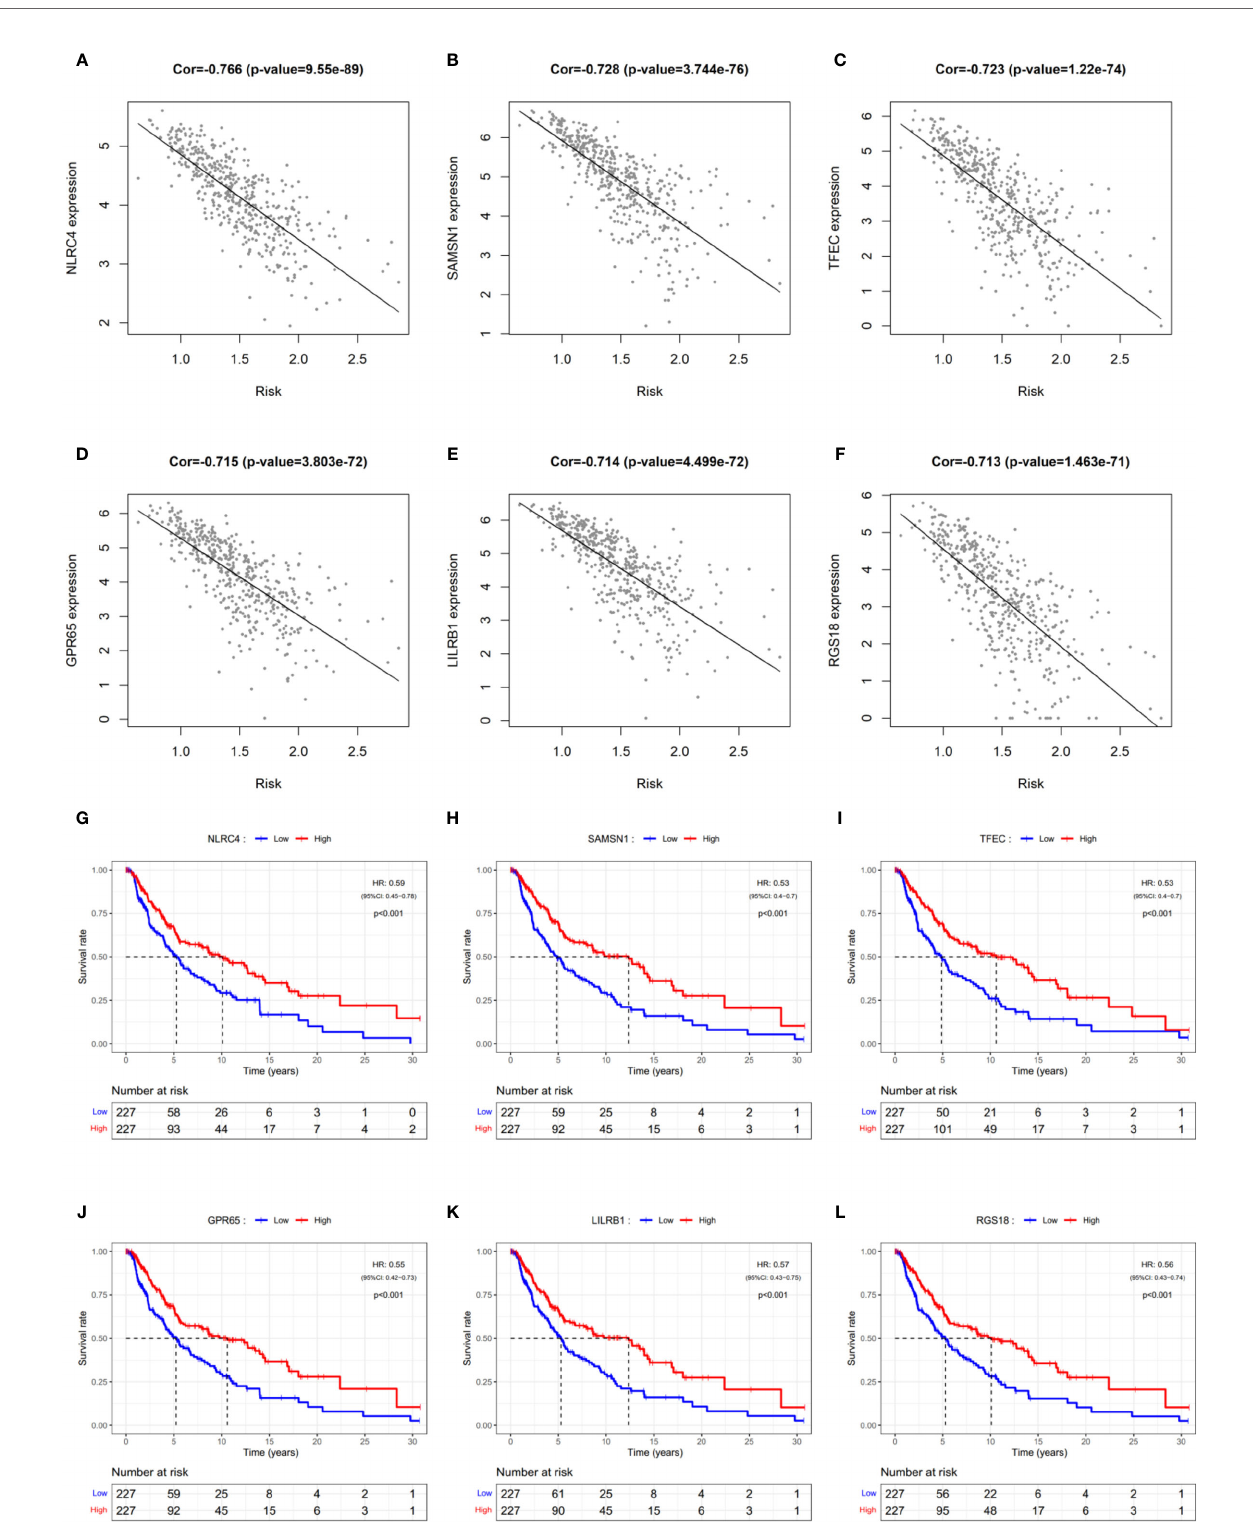
FIGURE 8 | Identi fi cation of risk-related genes. (A – F) Representative results of correlation analysis between the risk score and each gene in SKCM. Cor: correlation coef fi cient. (G – L) KM curves showing the relationship between the six most relevant genes and OS. HR, hazard ratio. CI, con fi dence